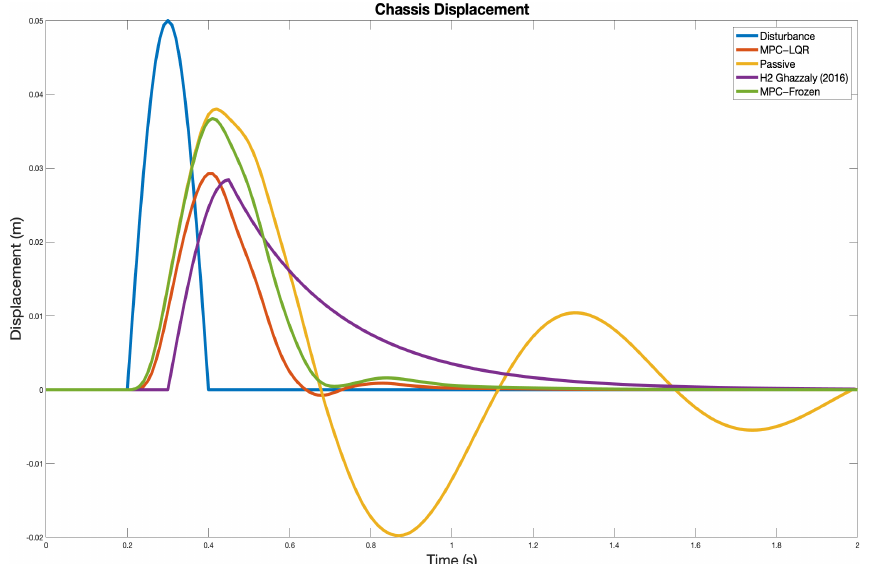
Figure 7. Chassis displacement—Bump Disturbance (Blue—disturbance, Red—MPC-LQR, Yellow— Passive, Purple—H2, Green—MPC-Frozen).